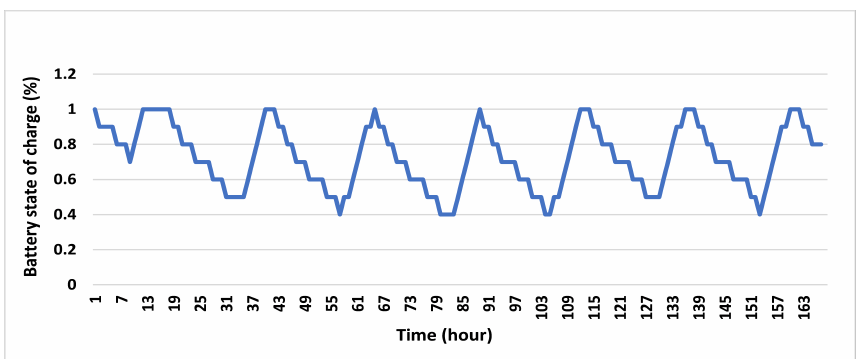
Figure 8. Microgrid operation during a week in the dry season: Case 1.